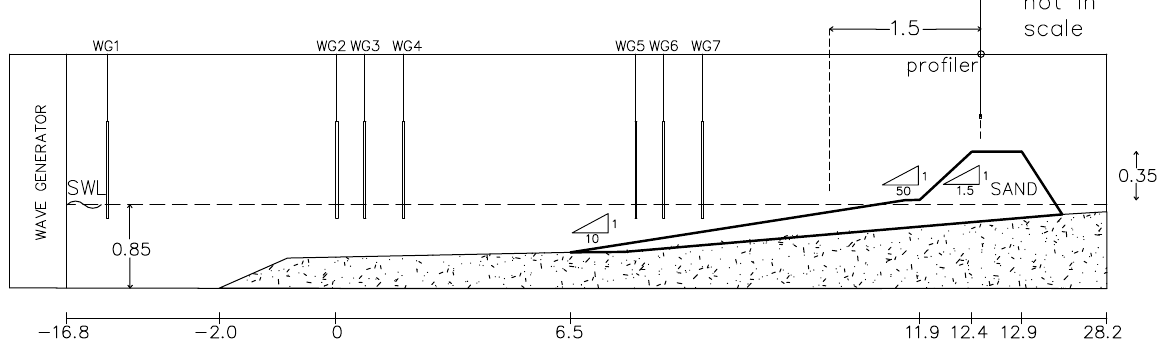
Table 3. Onshore coordinate X and water depth below SWL at WG1-WG7.